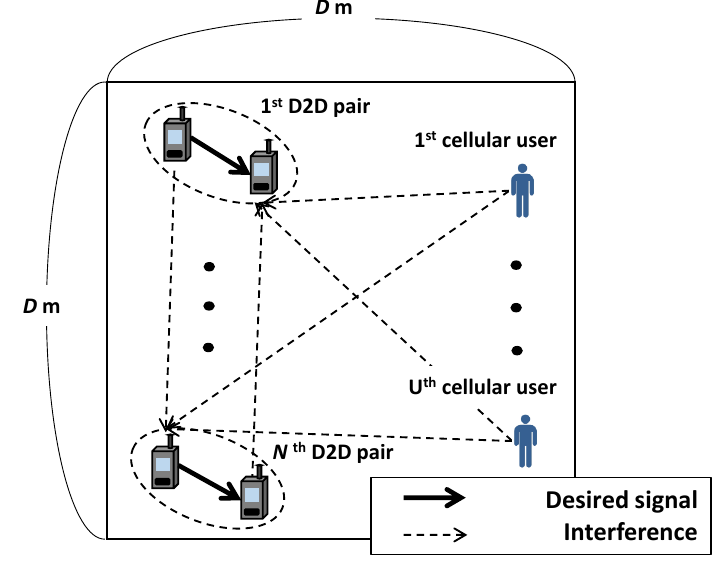
Figure 1. System model for transmit power